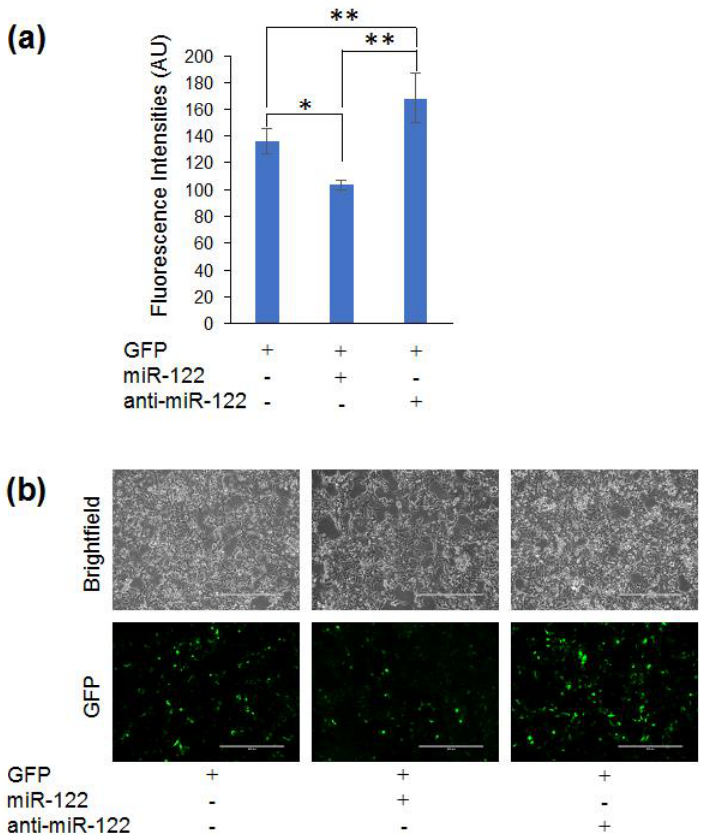
Figure 5. MiRAR-miR-122: Reporter gene construct for cellular miR-122 levels. Fluorescence intensities ( a ) for HEK 293 cells co-transfected MiRAR-miR-122 (CPEB- 3′ UTR) and miR-122 or anti-miR-122. HEK 293 cells were grown to 60 – 80% confluency and treated as indicated. Fluorescence intensities were measured by the Synergy H1 microplate reader at an excitation of 480 nm and emission of 509 nm. Error bars represent one standard deviation. ( a ) Cells transfected with 100 nM RNA; ( b ) MiRAR cell images of cells treated with RNAs as indicated. White bars show 400 µm. p values are * < 0.05 and ** < 0.01. AU: arbitrary units.